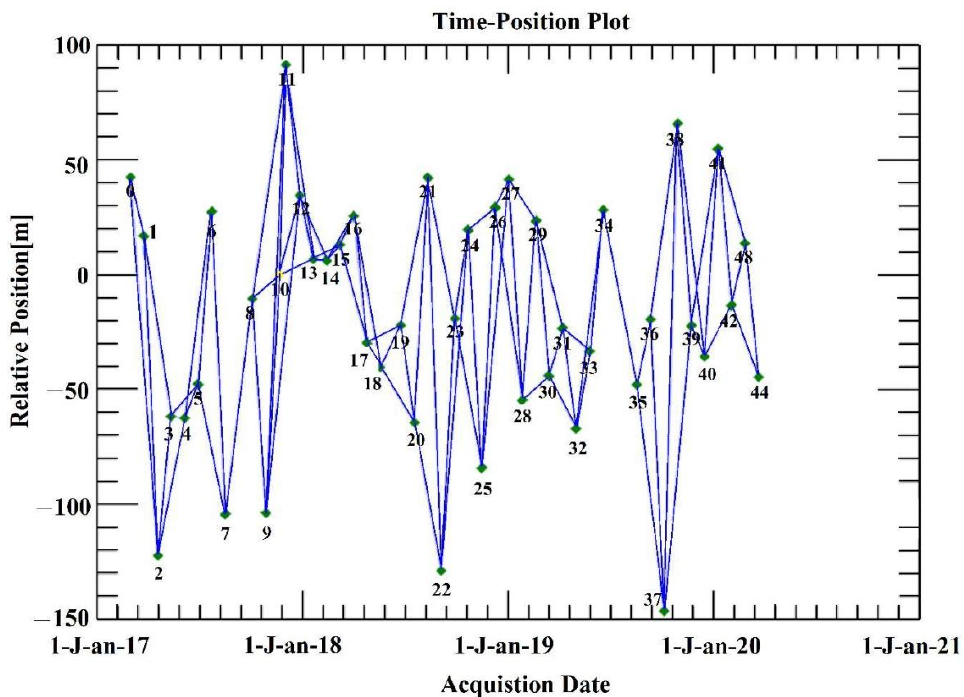
Figure 5. Spatiotemporal baseline of the SAR images.